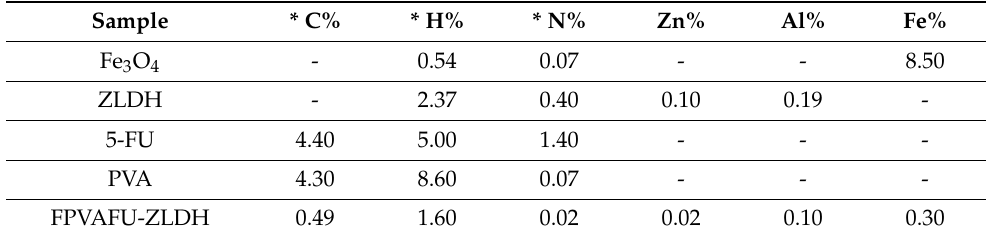
Table 4. Percentage of elements of the sample obtained by EDX analyses.